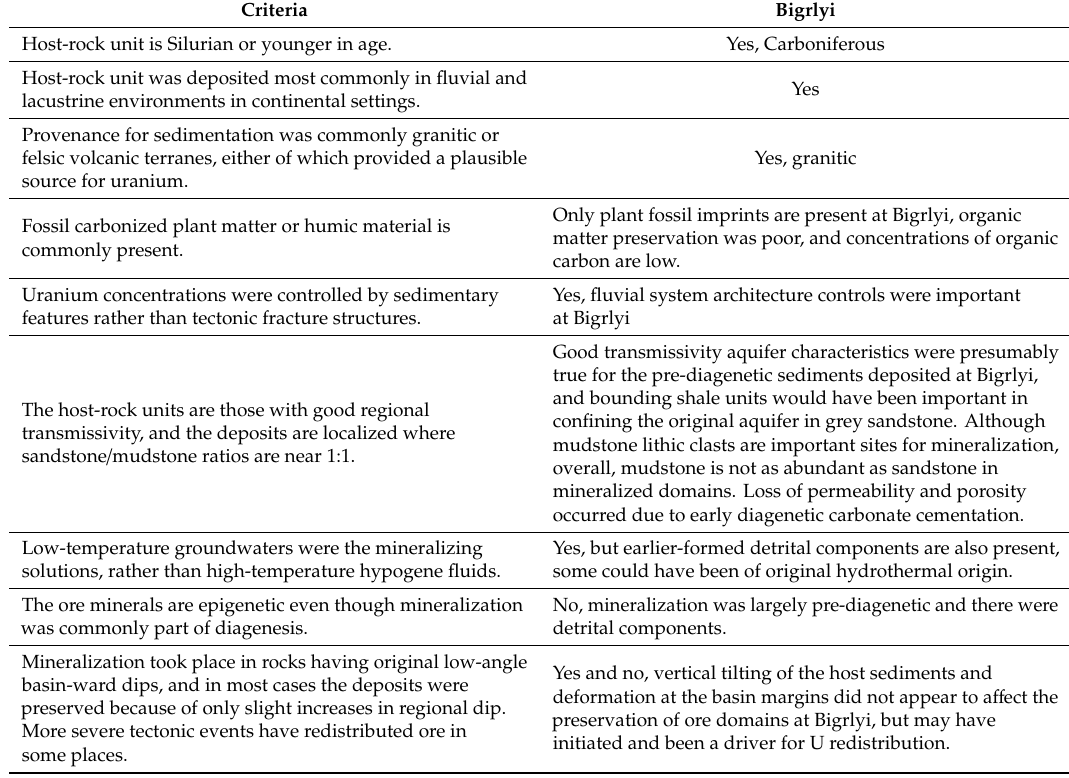
Table 4. Comparison Bigrlyi Deposit–Finch and Davis Sandstone-hosted U-V Deposit Criteria.